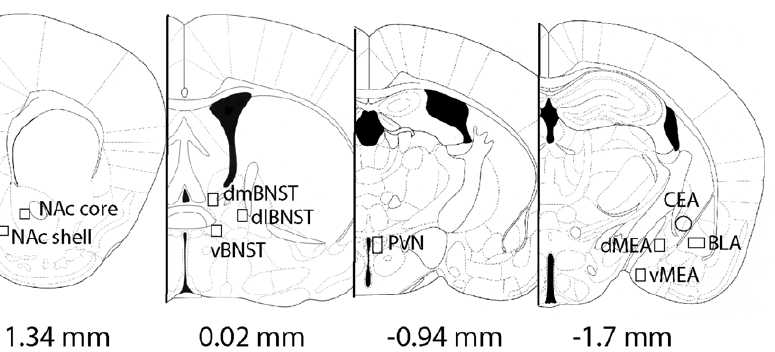
Figure 2. Representation of areas quantified using microscopic analyses in experiment 1. Reproduced from Paxinos & Franklin (2003), with permission from Academic Press. Abbreviations: Nucleus accumbens (NAc), dorsomedial bed nucleus of the stria terminalis (dmBNST), dorsolateral bed nucleus of the stria terminalis (dlBNST), ventral bed nucleus of the stria terminalis (vBNST), paraventricular nucleus (PVN), basolateral amygdala (BLA), central nucleus of the amygdala (CEA), dorsomedial amygdala (dMEA), dorsoventral amygdala (vMEA).